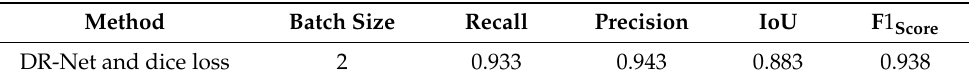
Table 4. The performance of DR-Net with dice loss (in the training process, the batch size was set to 2).